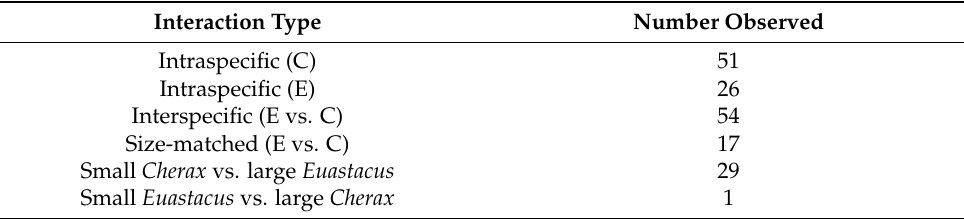
Table 2. The number of intraspecific interactions between Cherax destructor (C) and Euastacus dharawalus (E) and the total number of interspecific interactions observed. The number of inter- specific interactions that were size-matched, small C. destructor versus large E. dharawalus and small E. dharawalus versus large C. destructor are also listed.